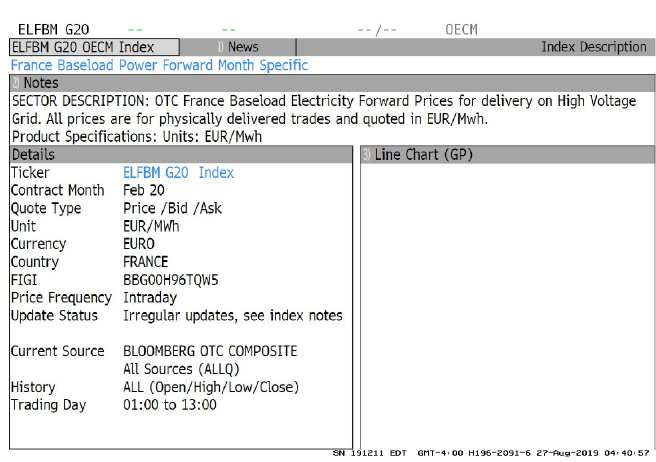
Figure 6. Ticker Bloomberg: ELFBM F20.